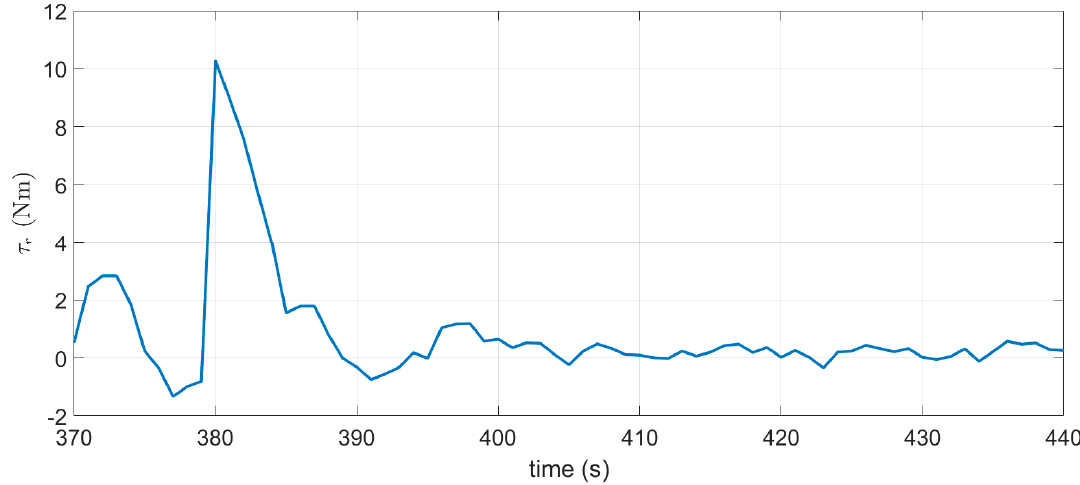
Figure 16. Experimental control input of robust adaptive control in the water tank.